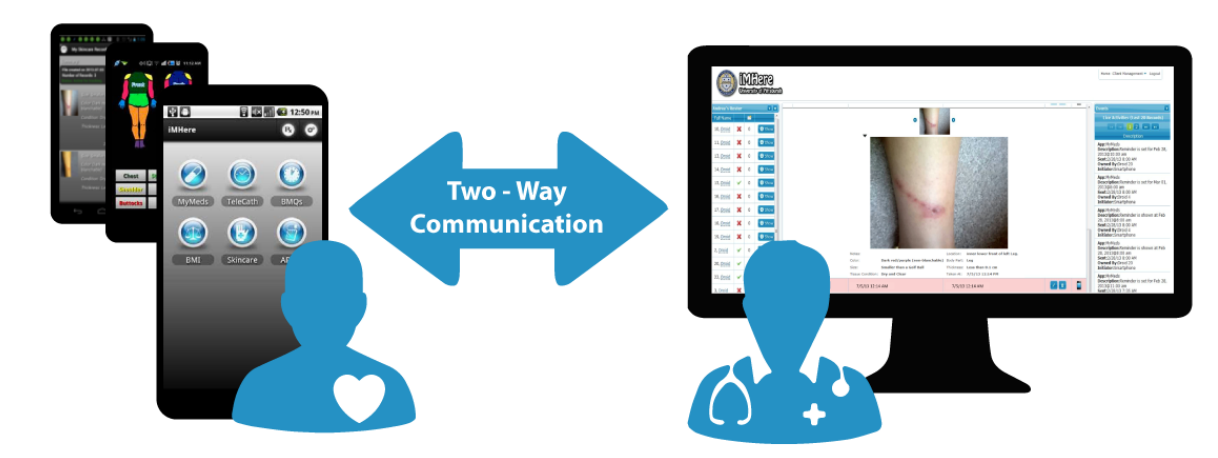
Figure 1. Architecture of the iMHere (interactive mobile health and rehabilitation)